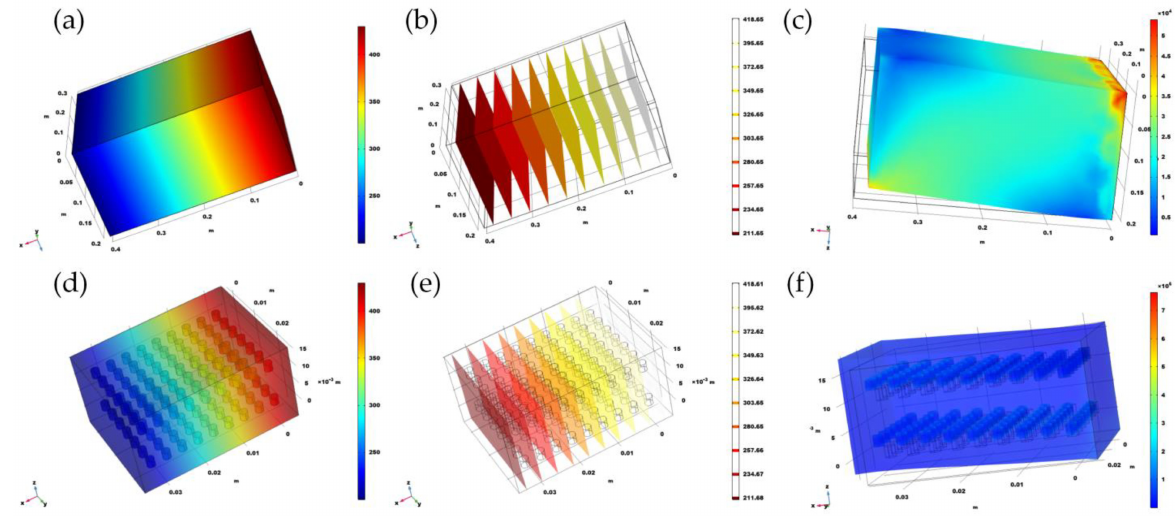
Figure 7. Simulation diagram of thermal isotherms before and after doping: ( a ) Temperature dis- tribution without thermal conductivity particles; ( b ) isotherm distribution without adding thermal conductivity particles; ( c ) stress analysis simulation of PDMS without thermal conductivity particles; ( d ) temperature distribution after doping with thermal conductivity particles; ( e ) isotherm distribu- tion after doping with thermal conductivity particles; ( f ) Stress analysis simulation of PDMS with high thermal conductivity